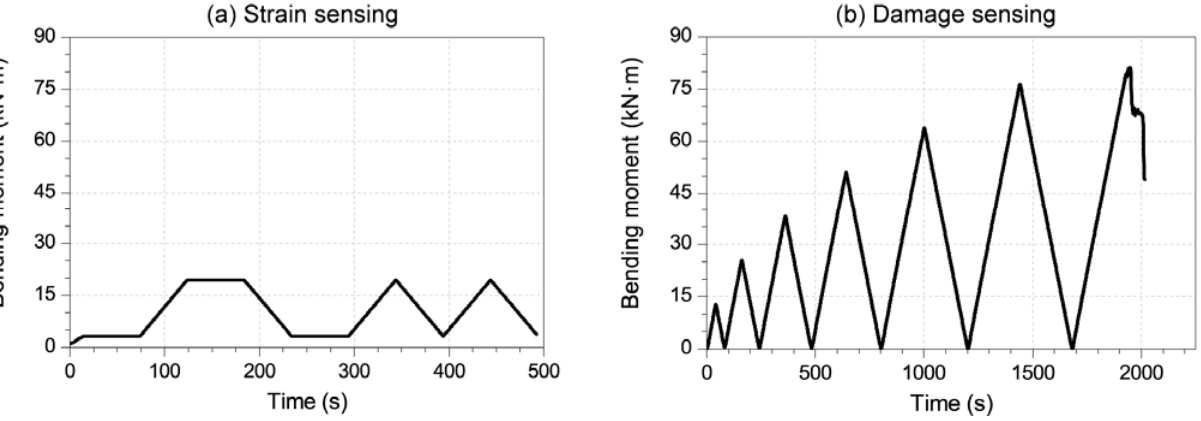
Figure 3. Loading configuration during: ( a ) strain-sensing tests; ( b ) damage-sensing